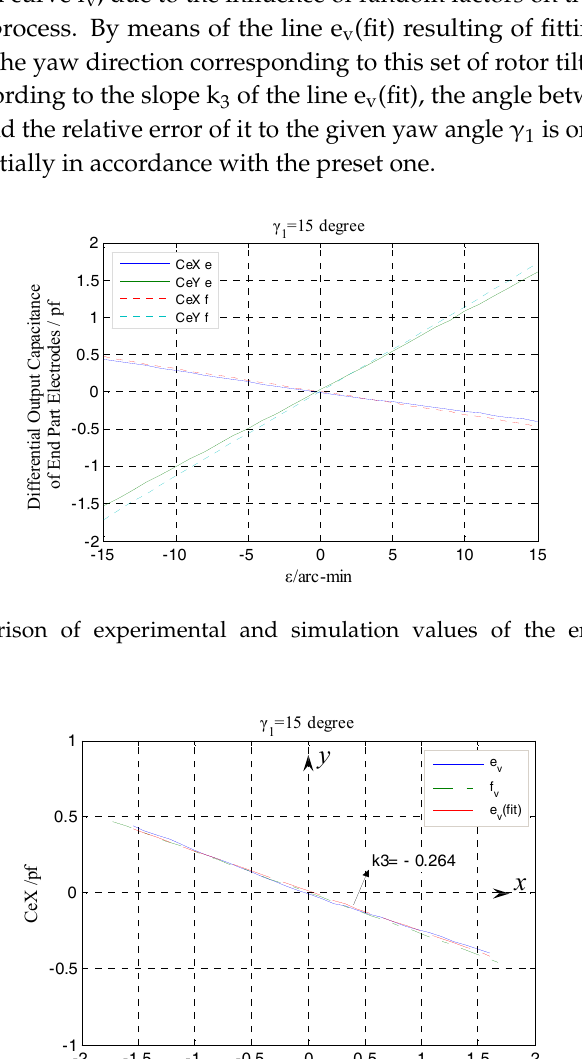
Figure 26. Comparison of experimental and simulation values of the end part fan-shaped electrode output capacitance: ( a ) Comparison between the second and fourth quadrants; ( b ) tilt schematic; ( c ) comparison between the first and third quadrants.